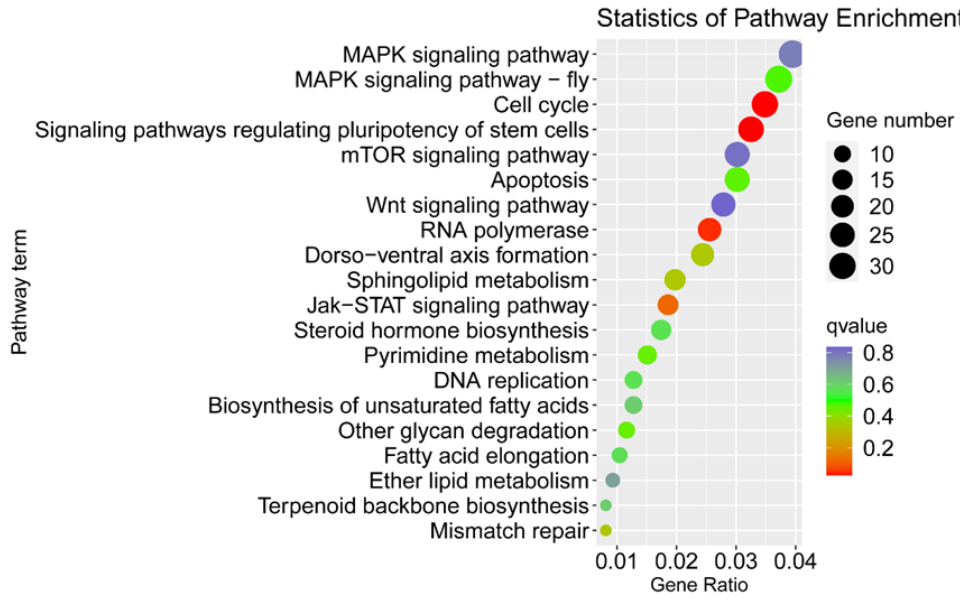
Figure 3. KEGG enrichment of the female-biased genes. The size of the dots corresponds to the number of DEPs in each pathway. The color displays the significance of enrichment.